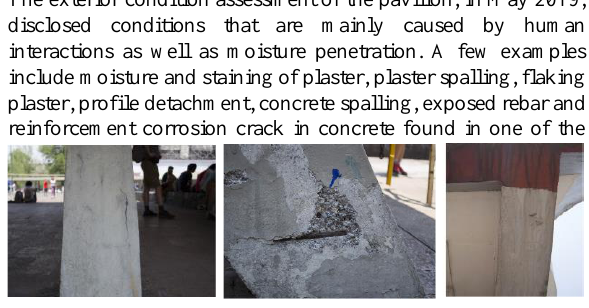
Figure 7. Exterior condition assessment. Left: exposed rebar reinforcement corrosion crack. Center: Concrete Spalling: Right: Moisture and Staining of Plaster (Pictures taken by Canadian